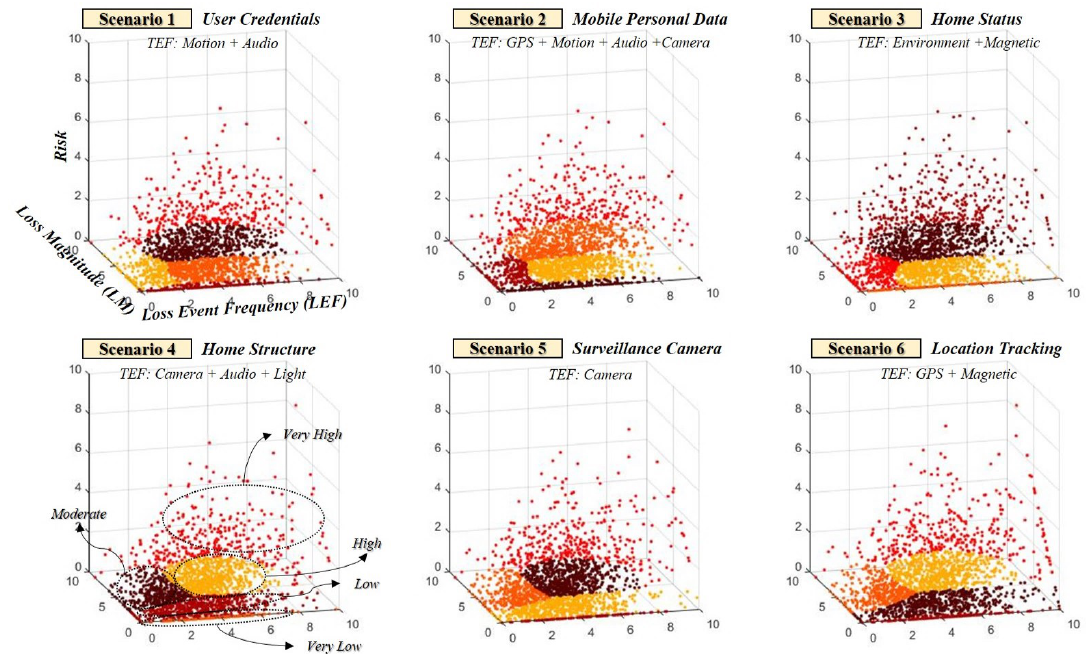
Figure 8. Relativity should be considered because criteria for risk grade range may change depending on the